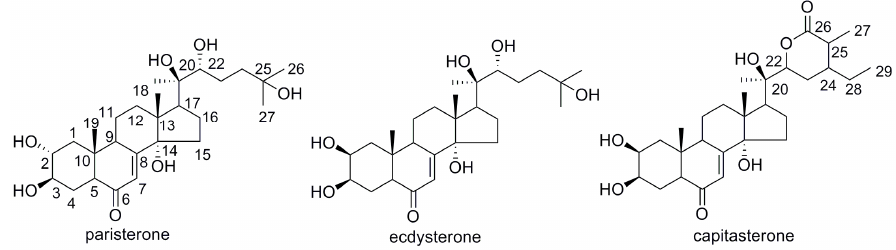
Figure 1. Chemical structures of three ecdysteroids from D. glaucescens ( I : paristerone; II : ecdysterone; III : capitasterone).